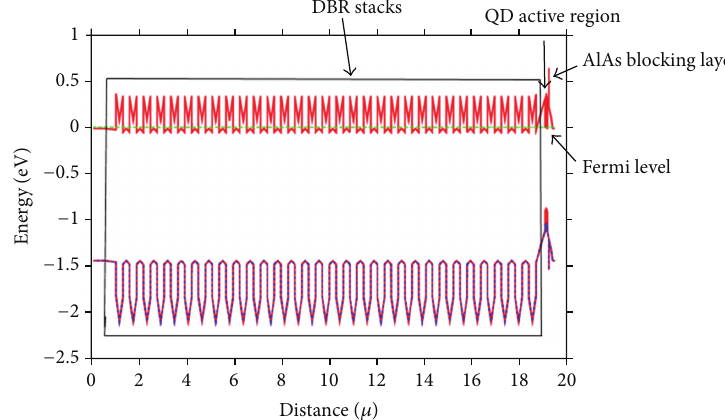
Figure 2: Energy band diagram profile along epitaxial growth direction under